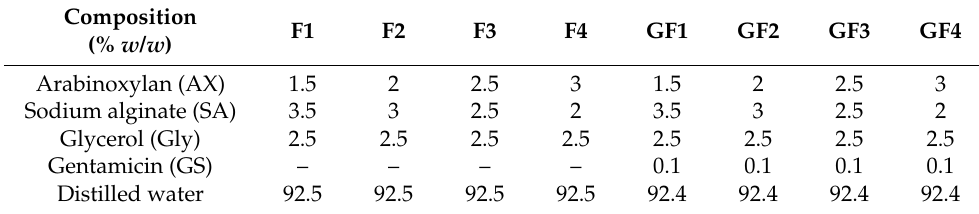
Table 1. Formulation codes and composition of arabinoxylan-sodium alginate (AXSA) films.